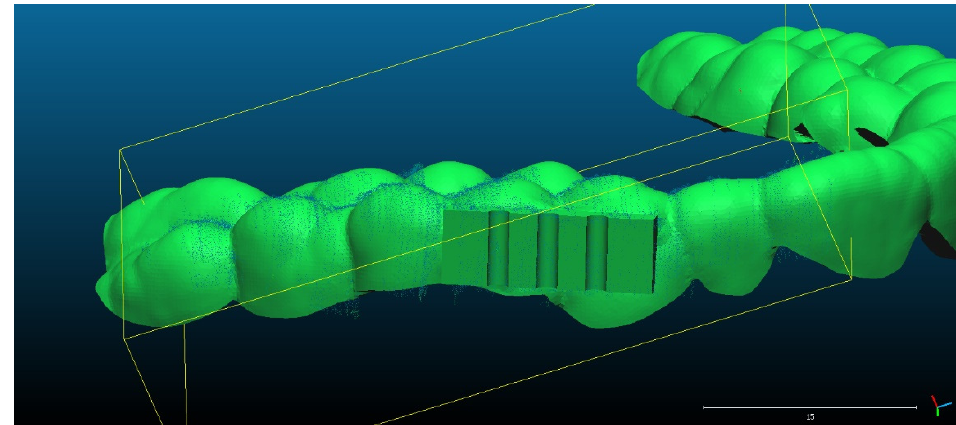
Figure 8. Scan 2 aligned with the reference object using CloudCompare software. Sensors 2022 , 22 , x FOR PEER REVIEW